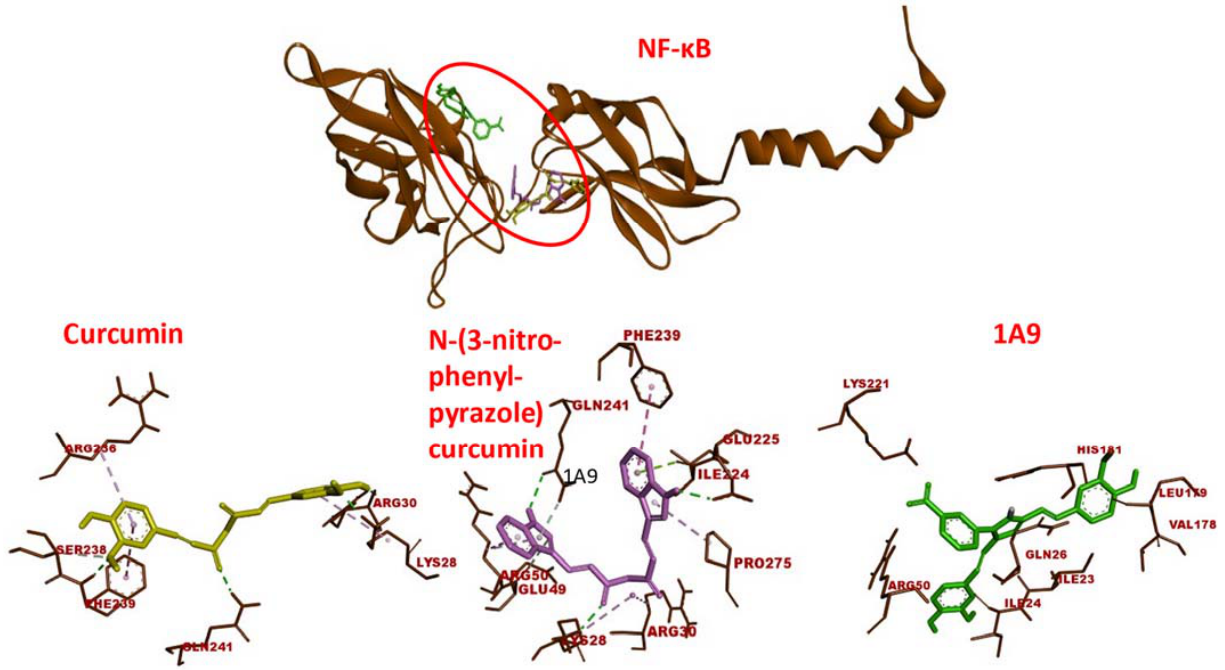
Figure 2. Molecular docking of curcumin ‐ type compounds to NF ‐κ B. Top: The compounds were bound to the same domain of EGFR. Bottom: curcumin, N ‐ (3 ‐ nitrophenylpyrazole) curcumin, and the derivative 1A9 were bound to different amino acids in this domain. The red circle indicates the binding site of the three compounds.